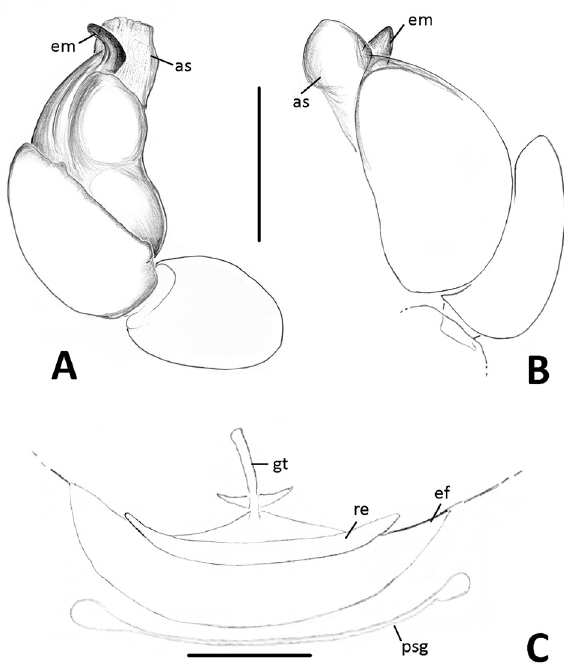
Figure 13. Pelicinus snooky n. sp., from Ethagala FR: A , left palp, prolateral view; B , male left palp, retrolateral view; C , fe- male epigastric region, dorsal view. Abbreviations: as , acces- sory structure; em , embolus; ef , epigastric furrow; gt , genitalic tube; psg , posterior spiracular groove; re , receptaculum. Scale bars: 0.1 mm.